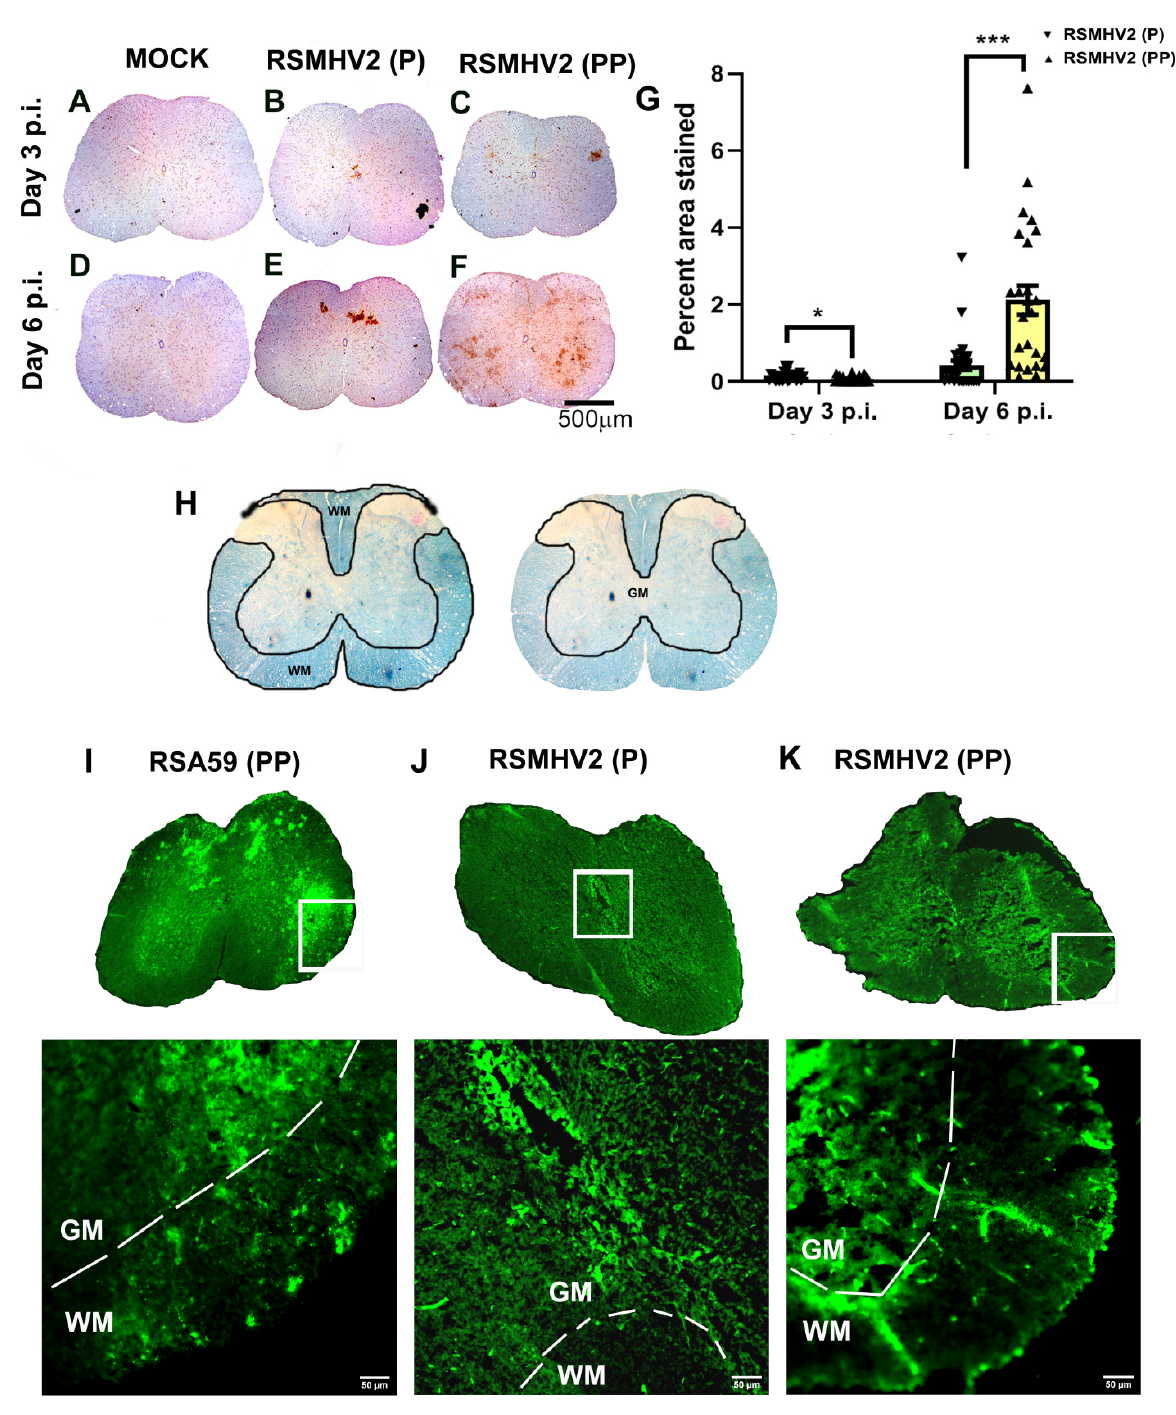
Figure 7. Differential distribution of viral antigen in RSMHV2 (P) and RSMHV2 (PP) infected mice spinal cord . Day 3 and Day 6 p.i. mock and viral infected spinal cord cross-sections were stained immunohistochemically (IHC) with anti-N antibody ( A – F ). No obvious staining was observed in any mock-infected sections ( A , D ). On day 3 p.i. in RSMHV2 (P) infected spinal cord viral antigen distribution was observed restricted around the central canal ( B ), whereas in RSMHV2 (PP) viral antigen distribution was apparent throughout the spinal cord including gray matter, gray-